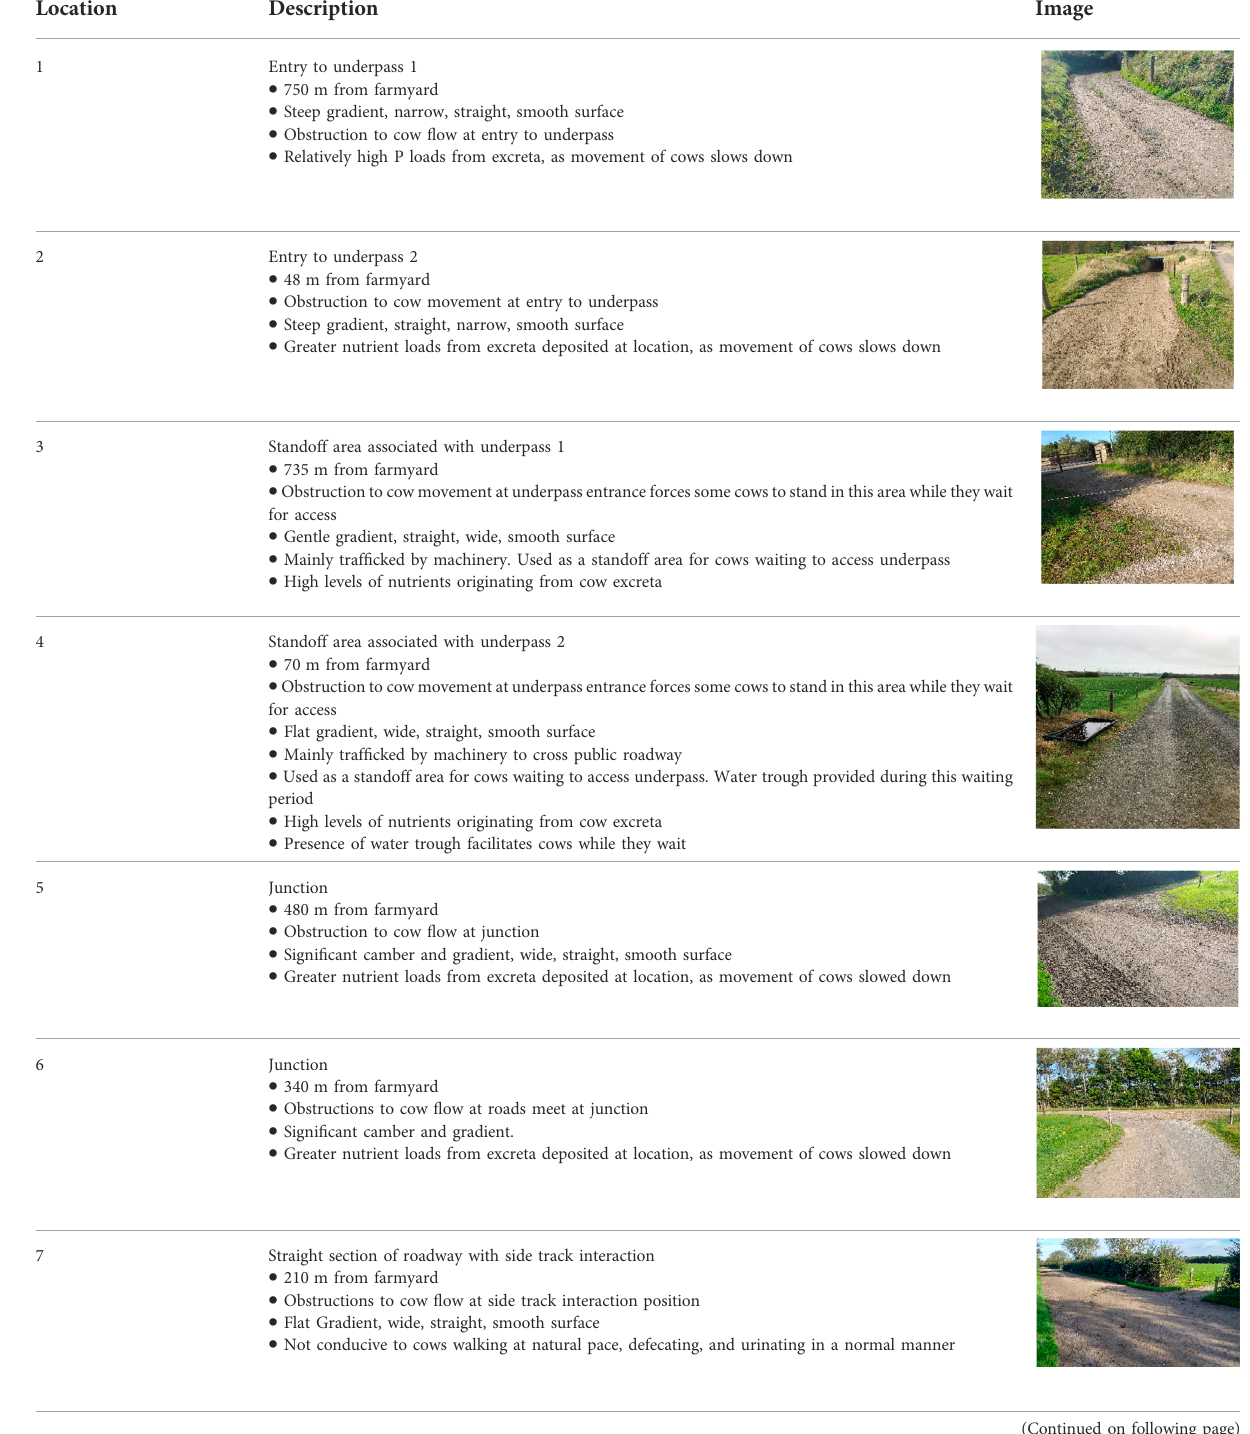
TABLE 1 General descriptions of sampling